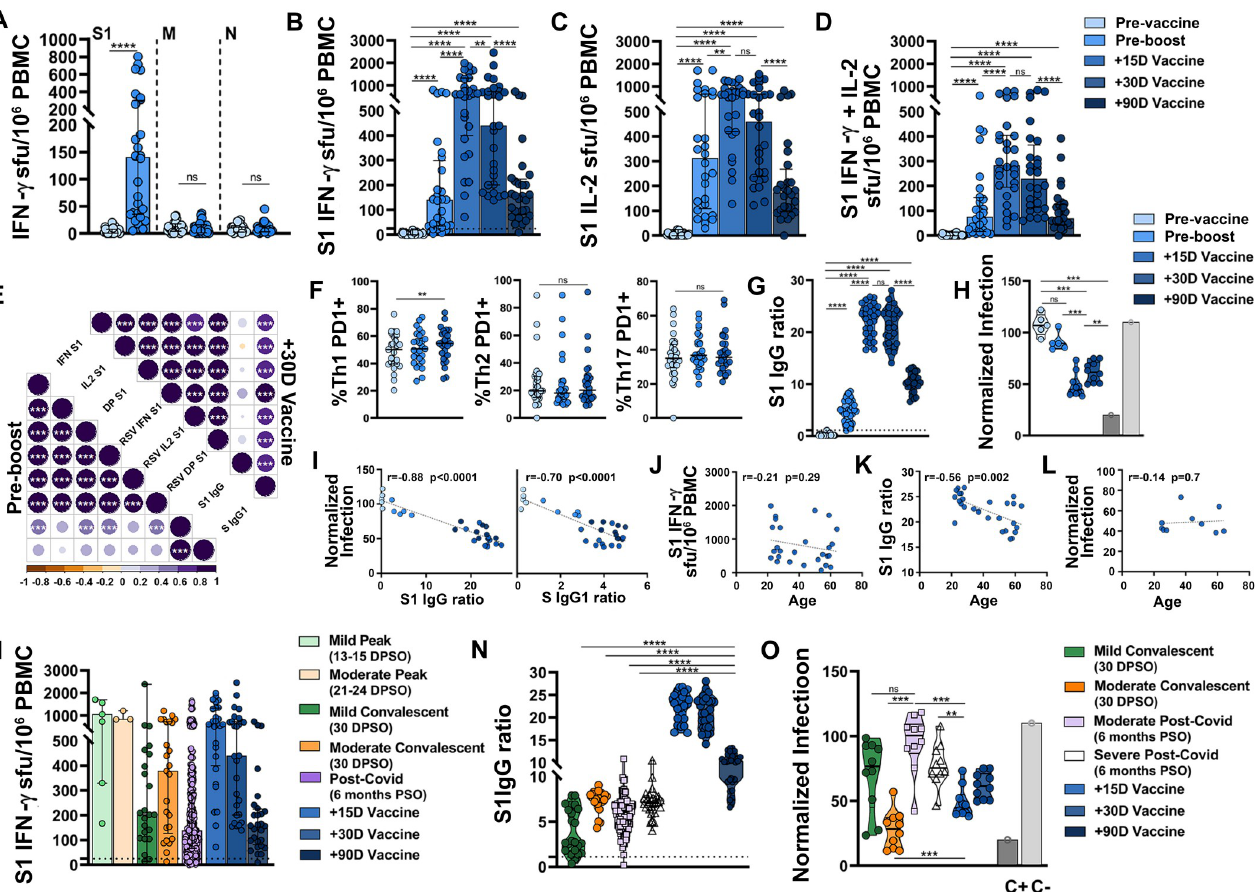
Fig 7. Development of SARS-CoV-2-specific cellular and humoral immunity after BNT162b2 vaccination. ( A ) IFN- γ -producing T-cell responses against S1, M and N proteins pre-vaccine and pre-boost. ( B-D ) S1 SARS-CoV-2-specific IFN- γ (B), IL-2 (C) and both cytokines (D) producing T-cells pre-vaccine, pre- boost and 15, 30 and 90 days after complete vaccination. Dashed line represents the positivity cut-off: > 25 IFN- γ sfu/10 6 PBMC. ( E ) Correlation matrix of adaptive immune variables analyzed. Only significant correlations (p < 0.05) are represented with asterisks. ( F ) Frequency of CD4 Th1, Th2 and Th17 PD1+ cells pre-vaccine, pre-boost and 15 days after complete vaccination. ( G ) Anti-S1 IgG results pre-vaccine, pre-boost and 15, 30 and 90 days after complete vaccination. Dashed line represents the positivity cut-off (ratio � 1.1). ( H ) Neutralization capacity pre-vaccine, pre-boost and 15 and 30 days after complete vaccination. ( I ) Correlation between neutralization and anti-S1 IgG (left) and anti-Spike IgG1 (right). ( J-L ) Correlation between age and S1 IFN- γ -producing T-cells (J), anti-S1 IgG (K) and neutralization (L) 15 days after full vaccination when the vaccine-elicited immune response peaked. ( M ) Comparison of S1 T-cell response between SARS-CoV-2 natural infection and complete vaccination. ( N-O ) Comparison of anti-S1 IgG (N) and neutralization (O) between SARS-CoV-2 natural infection and complete vaccination. Linear regressions were performed using Spearman’s rank test. Horizontal bars and whiskers represent median values and interquartile ranges, respectively. The significance between groups was determined using Mann Whitney, Wilcoxon signed rank or Kruskal-Wallis tests, � p < 0.05, �� p < 0.01, ��� p < 0.001, ���� p < 0.0001. DPSO: Days post symptom onset.